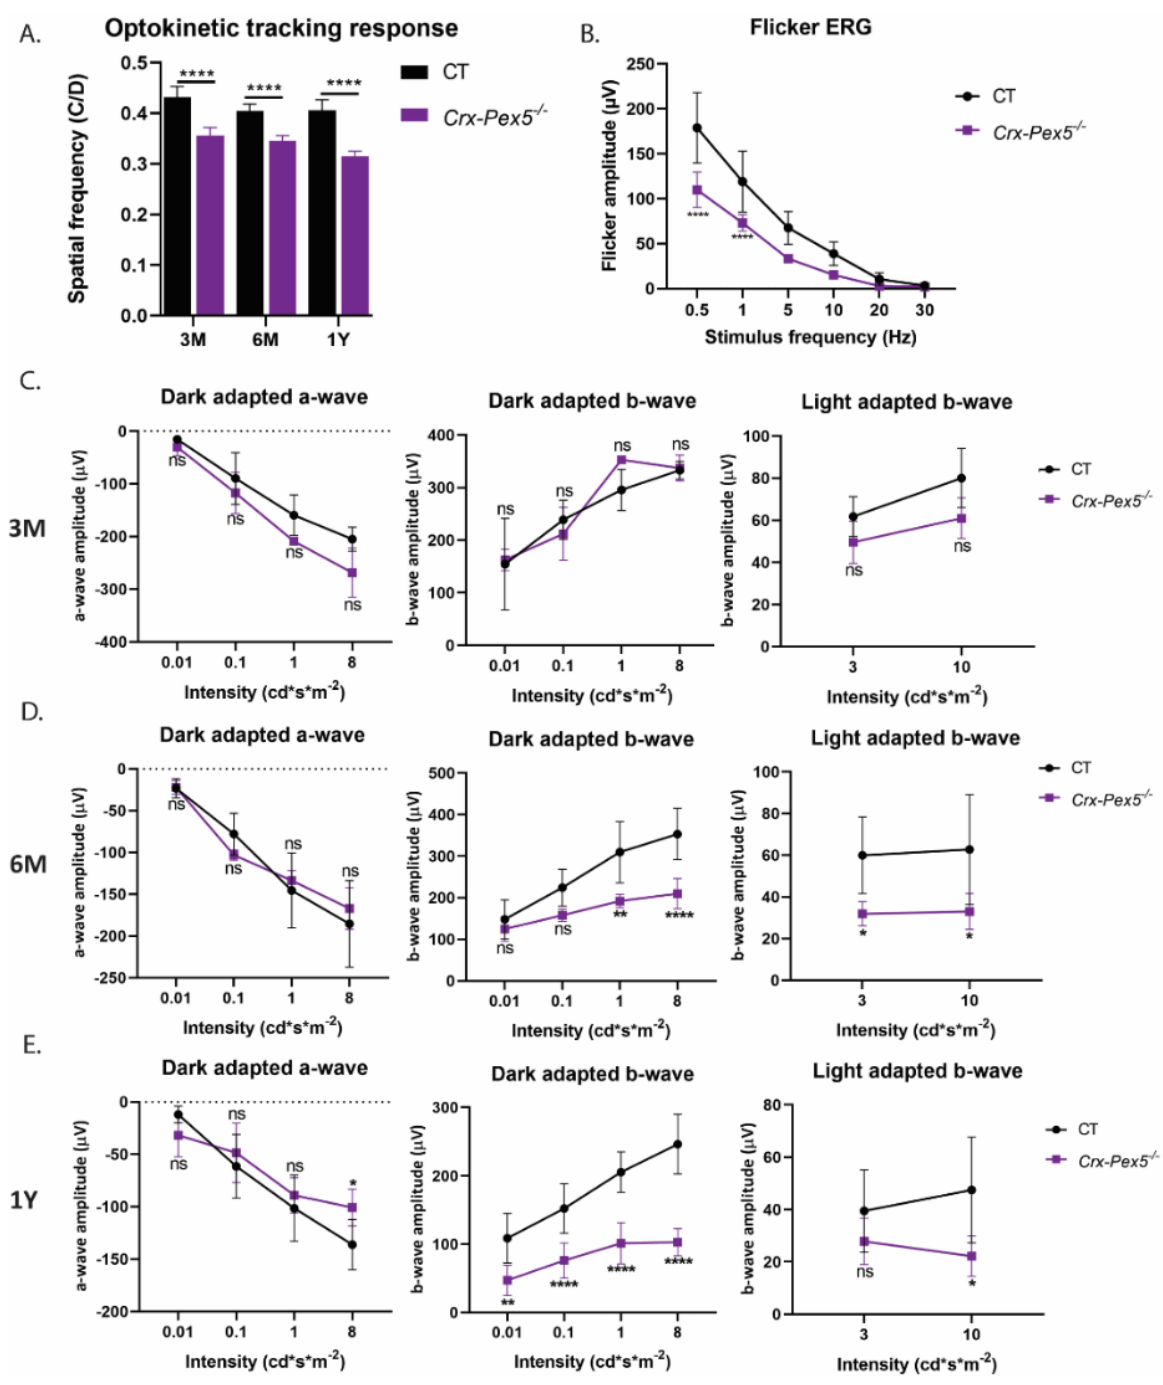
Figure 9. Reduced visual acuity and function in Crx-Pex5 − / − mice. ( A ) Optokinetic tracking response showed a significant reduction in visual acuity starting at 3 M. ( B ) Flicker ERG responses are lower in 6-month-old Crx-Pex5 − / − mice. ( C – E ) Scotopic and photopic b-wave responses are significantly affected in Crx-Pex5 − / − mice starting from 6 M of age. N = 4/group. Statistical difference based on two-way ANOVA and unpaired t -test: * p < 0.05, ** p < 0.01, **** p < 0.0001; ns—not significant. Error bars indicate